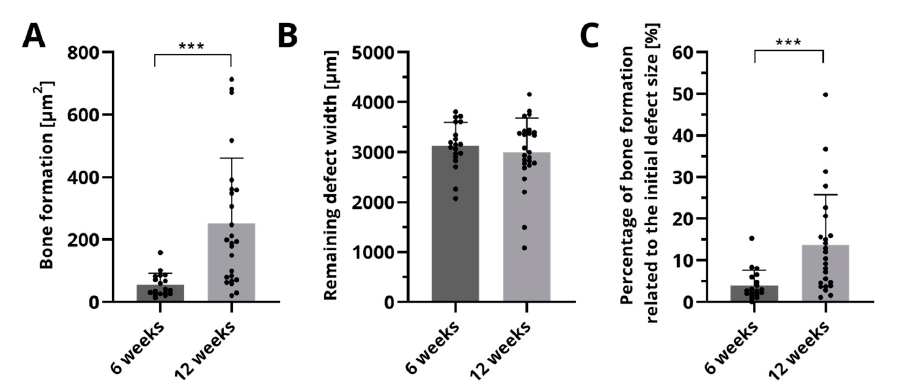
Figure 6. Histomorphometric analysis of bone formation ( A ), the remaining defect width ( B ) and the percentage of newly formed bone ( C ). Displayed are mean ± SD, *** p < 0.001, n = 19 and n = 25 for 6 and 12 weeks, respectively. The points mark the actual measured values of the histological sections.